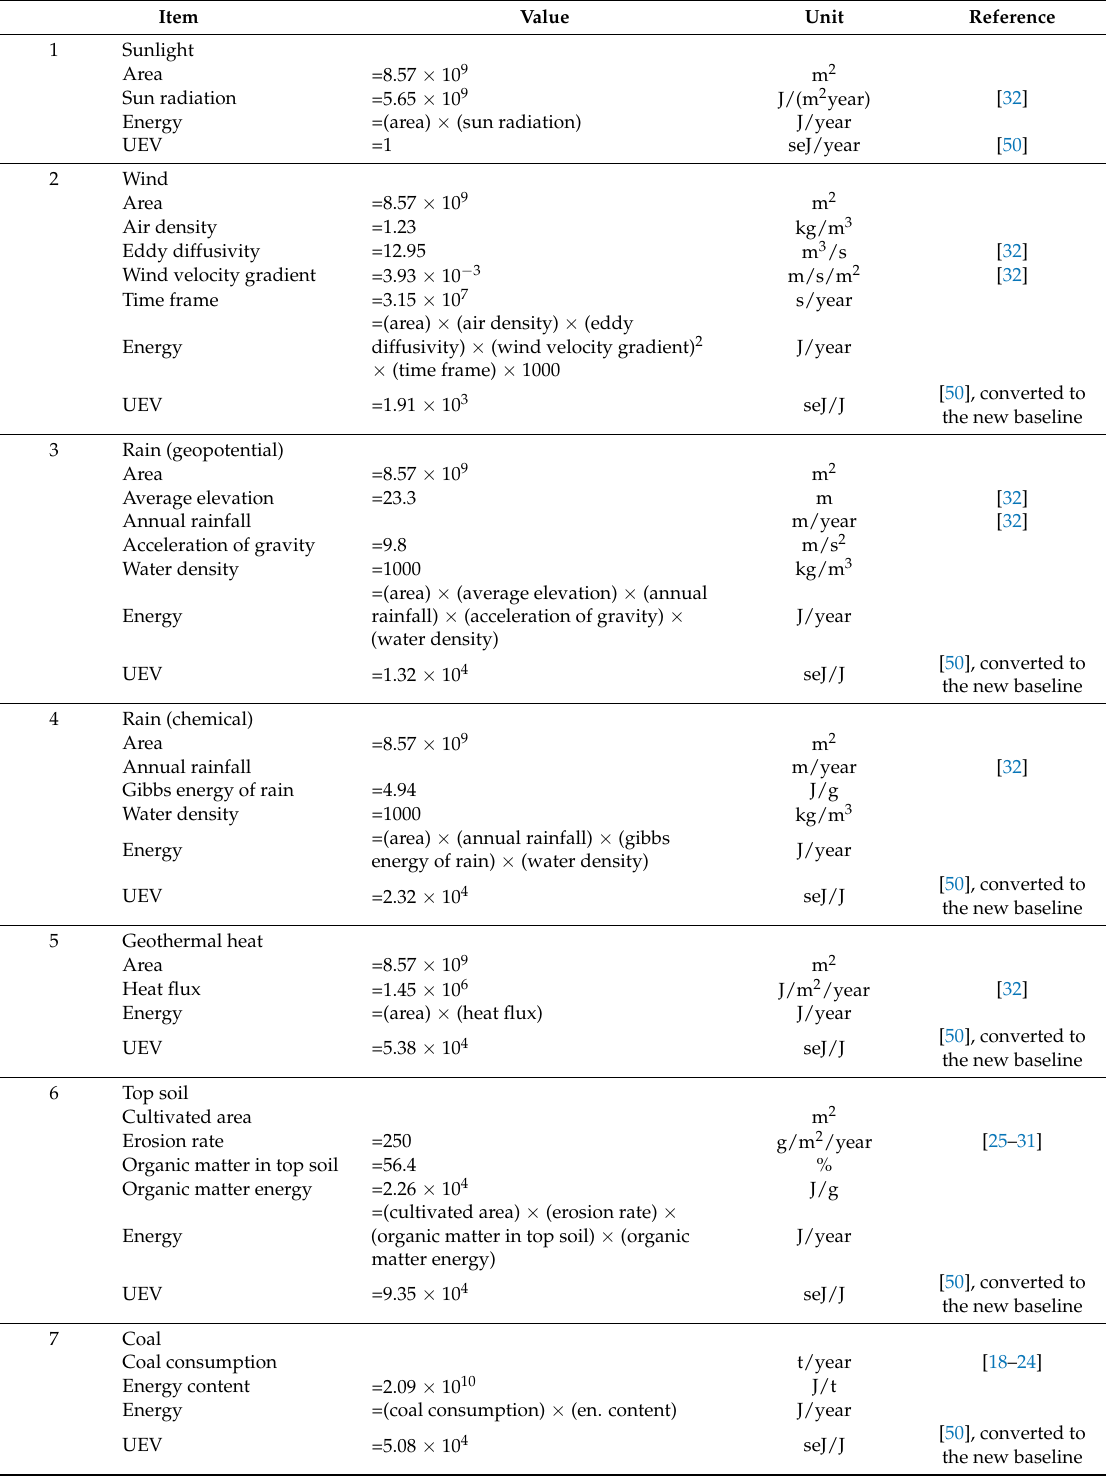
Table A1. Calculation procedure and references for unit emergy value